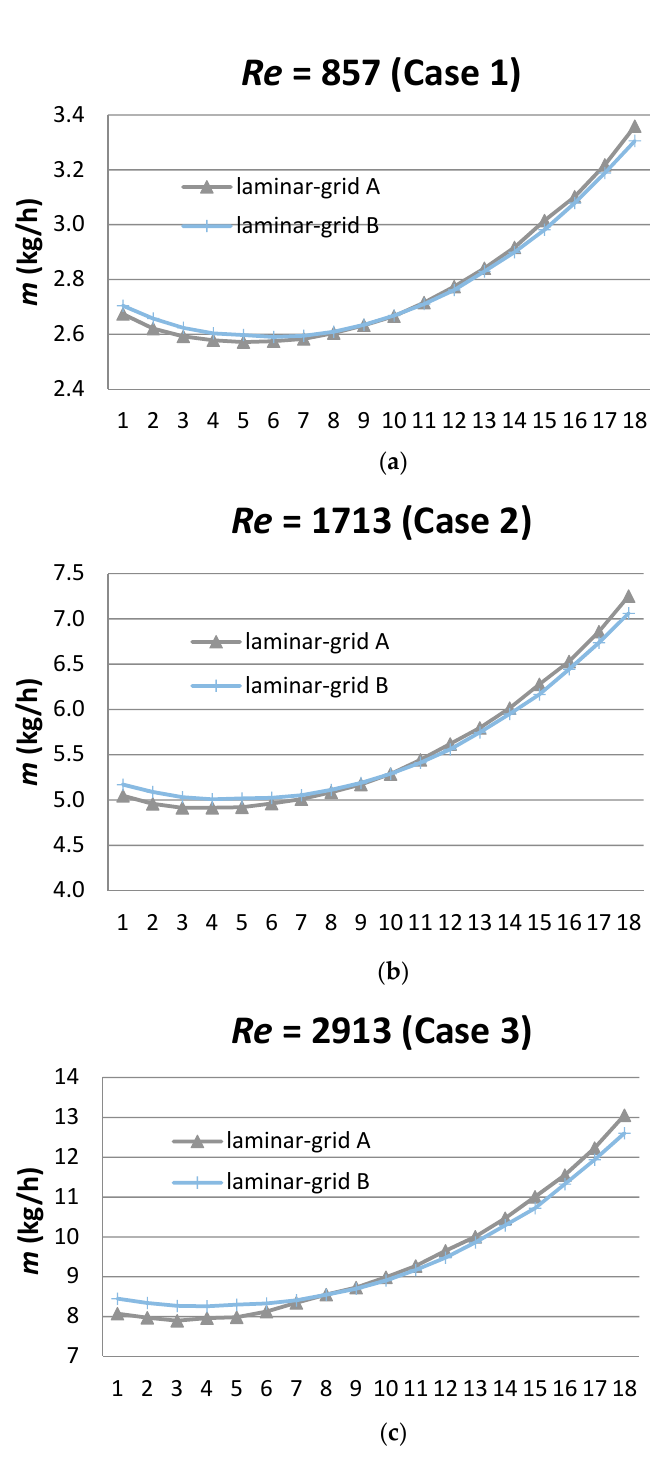
Figure 5 . Comparison of numerical results (laminar flow simulations in grids A and B). ( a ) Re = 857 (Case 1); ( b ) Re = 1713 (Case 2); ( c ) Re = 2913 (Case 3).